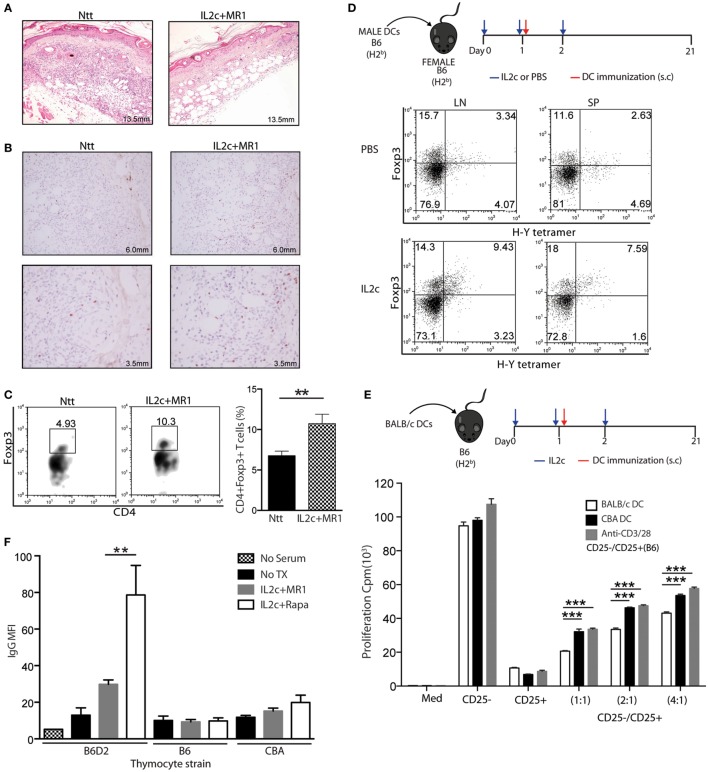
IL2c in combination with MR1 regulates donor-specific alloimmune responses. (A–C) Skin grafts from control non-treated (Ntt) and IL2c + MR1-treated tolerant mice were analyzed at day 7. (A) H&E staining. (B) Foxp3 immuno-staining. (C) Frequency of CD4+Foxp3+ T cells. (D) Frequency of I-Ab H-Y tetramer+ CD4+Foxp3+ T cells in lymph nodes and spleen from PBS- or IL2c-treated female B6 mice, immunized with male B6 dendritic cells (DC). (E)
In vitro rechallenge assay. CD25− and CD25+ CD4+ T-cell subsets were isolated from IL2c-treated B6 mice at day 21 after immunization with 5 × 105 BALB/c DC and cocultured at different ratios in the presence of allogeneic or third party CBA DC, or polyclonal stimulation. (F) Presence of donor-specific IgG antibodies in the serum of non-transplanted, graft rejected (IL2c + rapamycin), or tolerant (IL2c + MR1) mice. Donor (B6D2), syngeneic (B6), or third party (CBA) strains thymocytes were used. Representative histology and flow cytometry stainings are shown from one out of 3–4 mice/group. All in vitro cultures were done in triplicates and are representative of two independent experiments. Bar graphs indicate mean ± SEM (*P < 0.05, **P < 0.01, and ***P < 0.001).